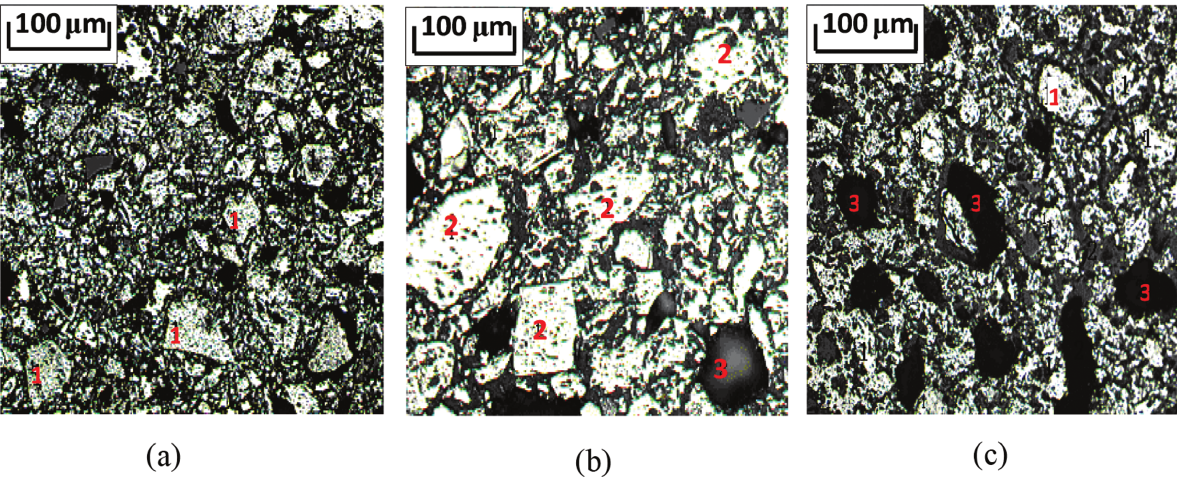
Figure 9: Optical microstructures of fired pellets at different coke fines dosage (Preheating at 1,050°C for 15 min and firing at 1,250°C for 15 min).